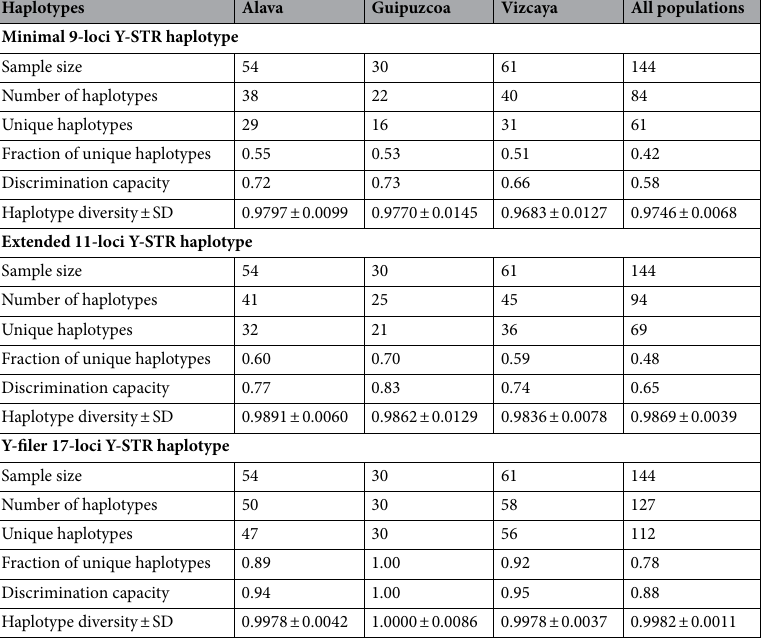
Y‑STR haplotypes. Pairwise Rst genetic distances and the corresponding P values among Alava, Guipuzcoa and Vizcaya and the 30 geographically targeted reference populations are presented in Supplementary Table 10. The lowest Rst distances were detected among Alava, Guipuzcoa and Vizcaya populations. Comparisons between Alava, Guipuzcoa and Vizcaya, and the reference populations generated close Rst distances in relation to Basque Country, Gascony, Ireland, USA Basques, Andalusia and Spain (Supplementary Table 1), the lower distances in the order listed. Subsequent to the application of the Bonferroni adjustment for potential type I errors (α/m = The Phylogenetic relationships among the three autochthonous Basque populations under study and the 30 geographically targeted key reference populations were evaluated using MDS analysis based on the Rst distances (Fig. 2). In the MDS graph, the populations from Alava, Guipuzcoa and Vizcaya segregate together in a cluster with the reference groups from the Basque Country (general population), Gascony, Ireland and the USA Basques to the right-center of the plot. Further to the left along the X-axis, the rest of the Western European populations form a cluster. The Eastern European reference populations follow to the left along the X-axis. The West Asian, Arabian and North African groups partition widely along the Y-axis at the far left of the graph. The groups of Africa and South Asian ancestry living in the United Kingdom are disperse within this last loose cluster. Within the European populations, the partitioning in the plot mirrors their west to east geographical distribution. The NJ projection based on different algorithms (Fig. 3) illustrates the same general topology for the European popula- tions as the MDS graph. The cluster made up of Alava, Guipuzcoa, Vizcaya and the reference groups from the Basque Country, Gascony, Ireland and the USA Basque in the MDS plot (Fig. 2) also partition in proximity in the NJ tree with bootstrap values ranging from 100 to 40.6%. Of the populations in this Basque-Irish assembly, Alava segregates closer to non-Basque Western European populations. Discrete groupings of the Balkan region (Balkan, Macedonia, Romania and Greece), North African and Arabian populations are evident in the NJ tree. Yet, it is not clear why the United Kingdom populations of South Asian (UKS) and African (UKA) descend parti- tion together (bootstrap = 42%), since in the MDS plot these two populations do not segregate in close proximity. Population structure and age estimates of haplogroup R‑S116. to assess the genetic structure within haplogroup R-S116 (Fig. 4). The network was generated from the Y-STR haplotype data (DYS19, DYS389I/II, DYS390, DYS391, DYS392, DYS393, DYS437, DYS438, DYS439, DYS448, DYS456, DYS458, DYS635, Y-GATA H4) of the Alava, Guipuzcoa and Vizcaya populations (Supplementary Tables 5, 6 and 7). The network exhibits a symmetrical star-shape topology centered in an individual from Vizcaya. Most of the individuals are singletons or doubletons and there are only ten inter-population haplotype nodes, eight of which involve Alava and only two include the three autochthonous Basque populations. The network does not exhibit intra- or inter-population substructure. The population-specific haplotypes are dis- persed uniformly throughout the plot. Often individuals from different populations emanate from a different population-specific node. The vast majority of individuals are separated by one-step mutation event.